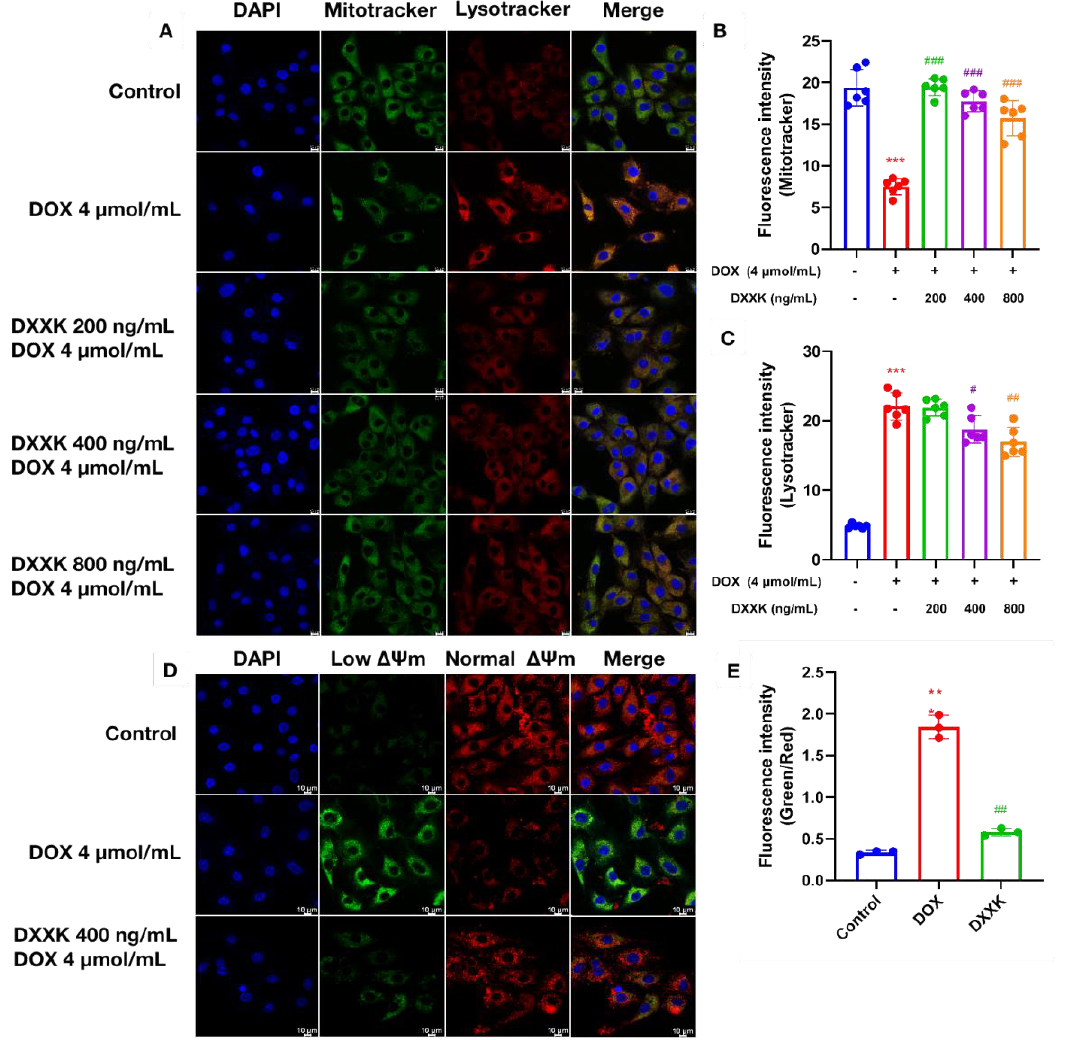
Figure 4. DXXK protects myocardial mitochondria from DOX-induced damage. ( A ) Observation of the number of mitochondria and lysosomes by laser confocal microscopy. Green fluorescence intensity represents mitochondria. Red fluorescence intensity represents the number of autophagosomes. ( B ) Green fluorescence intensity; ( C ) red fluorescence intensity; ( D ) observation of the mitochondrial membrane potential by laser confocal microscopy. ( E ) The higher the ratio of green fluorescence intensity to red fluorescence intensity, the lower the mitochondrial membrane potential. ** p < 0.01 and *** p < 0.001 compared with the control group. # p < 0.05, ## p < 0.01 and ### p < 0.001 compared with the DOX group.